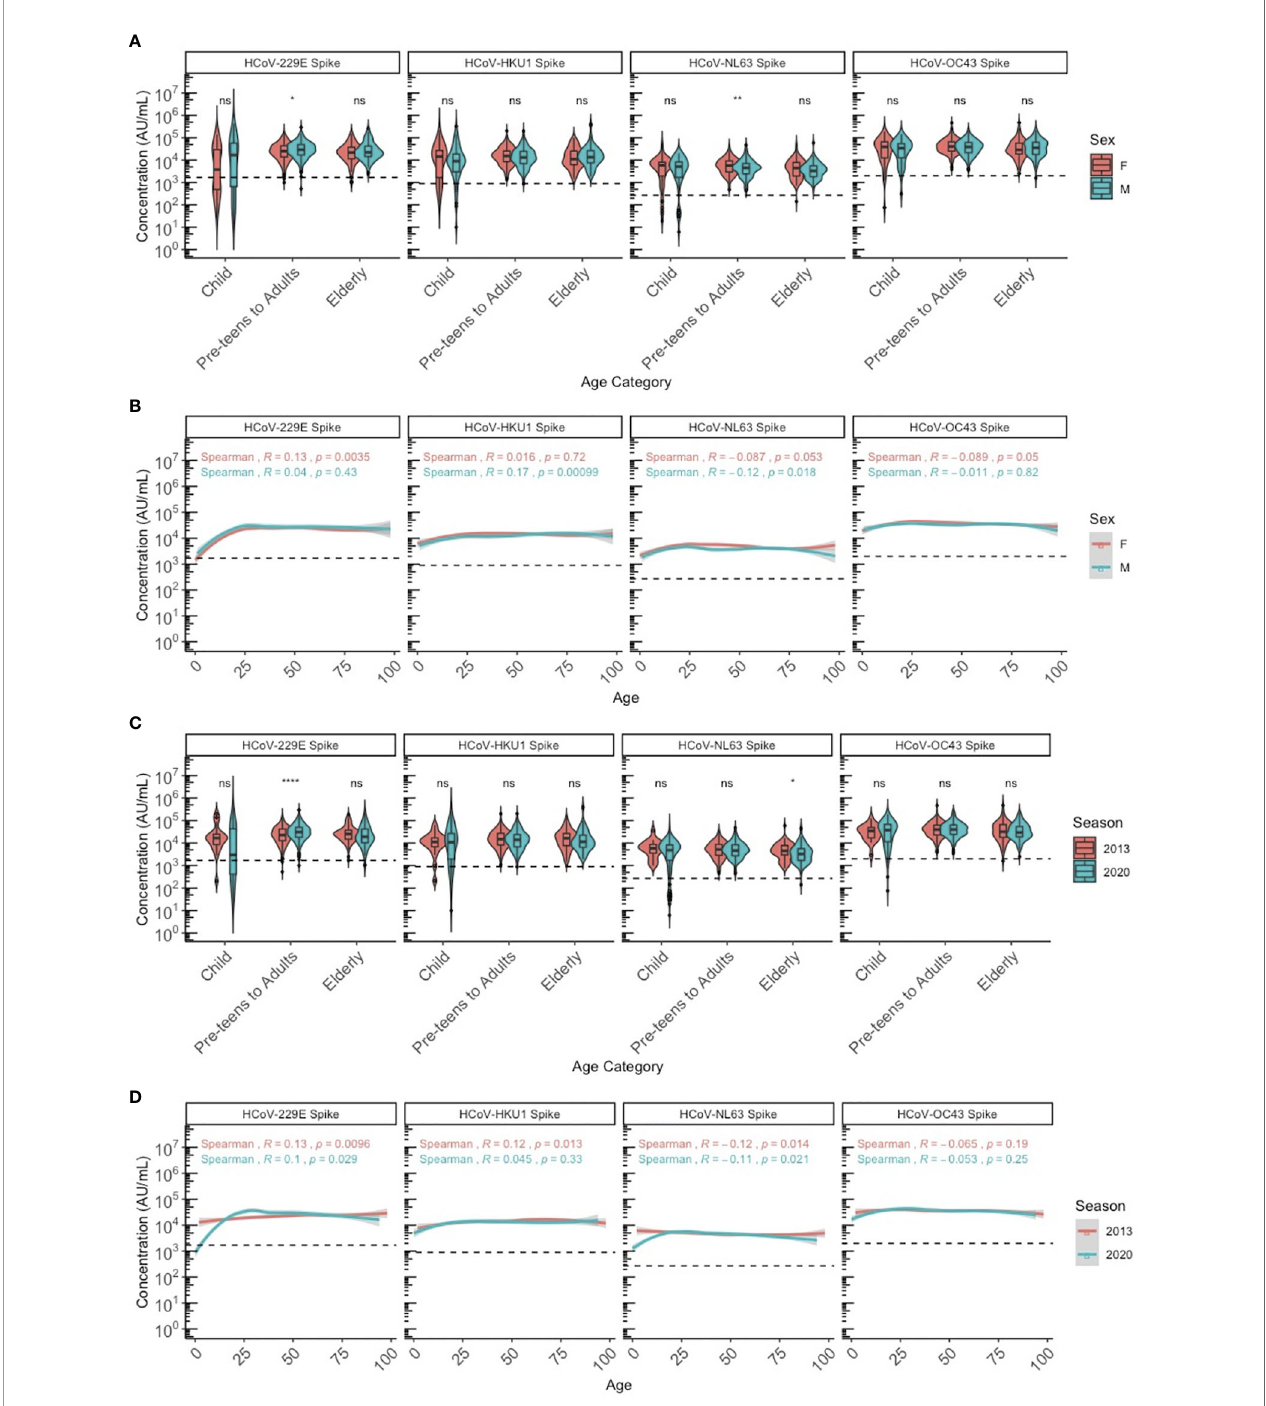
FIGURE 2 | HCoV-229E, HCoV-HKU1, HCoV-NL63, and HCoV-OC43 spike IgG antibody levels between sexes and seasons (2013 and 2020) by chronological age among SARS-CoV-2 sero-negative persons (N = 887). (A, B) describe the HCoV antibody levels between male and female sexes by (A) age category and (B) chronological age. (C, D) describe the HCoV antibody levels between 2013 and 2020 seasons by (C) age category and (D) chronological age. In (A, C) , age categories are strati fi ed according to children ( ≤ 10 years old), pre-teens to adults (11-69 years old), and the elderly ( ≥ 70 years old). Black dashed lines describe the positivity cutoff for each antigen target. Wilcoxon rank sum test was used to compare antibody levels between (A) sexes and (C) seasons. Spearman ’ s rank correlation was used to describe the relationship between antibody level and age in (B, D) , and Spearman ’ s correlation coef fi cient rho (R) and corresponding P-values (P) are reported. ns, not signi fi cant, * = p < 0.05, ** = p < 0.01 **** = p <